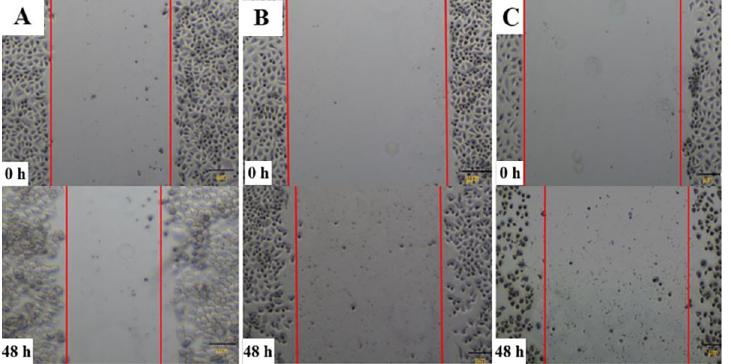
Fig 4. Comparison of wound gap between transfected and non-transfected cells. Wound healing assay was used to compare the ability of cells between the test groups to close the wound created on monolayer cells. The micrographs were taken for non-transfected (A), Hs.Cas9.MMP20.1.AA (B), and Hs.Cas9.MMP20.1.AB (C) transfected cells at 0 h and 48 h after creating the wound in the monolayer cells. All the images were taken with a magnification of ×